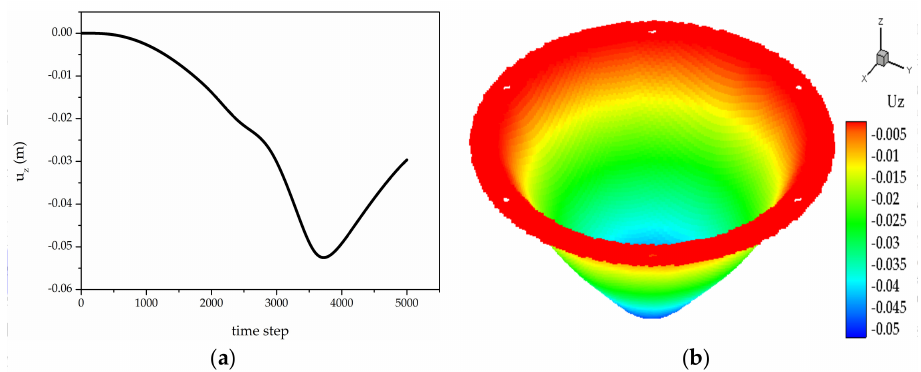
Figure 7. ( a ) Variation of the displacement in z direction of the central point as a function of time; ( b ) Vertical displacement distribution for the top ply at 0.28453 × 10 − 3 s.